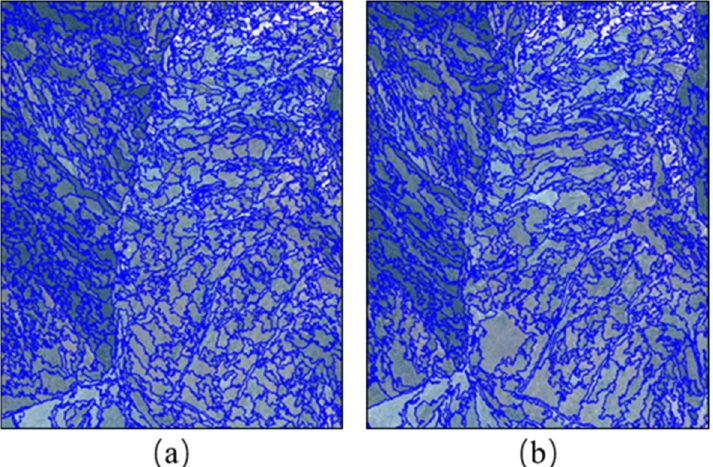
Figure 5. Comparison of different segmentation layers. ( a ) Segmentation result derived from the multispectral layers and DEM layer. ( b ) Segmentation result derived from the multispectral and deformations